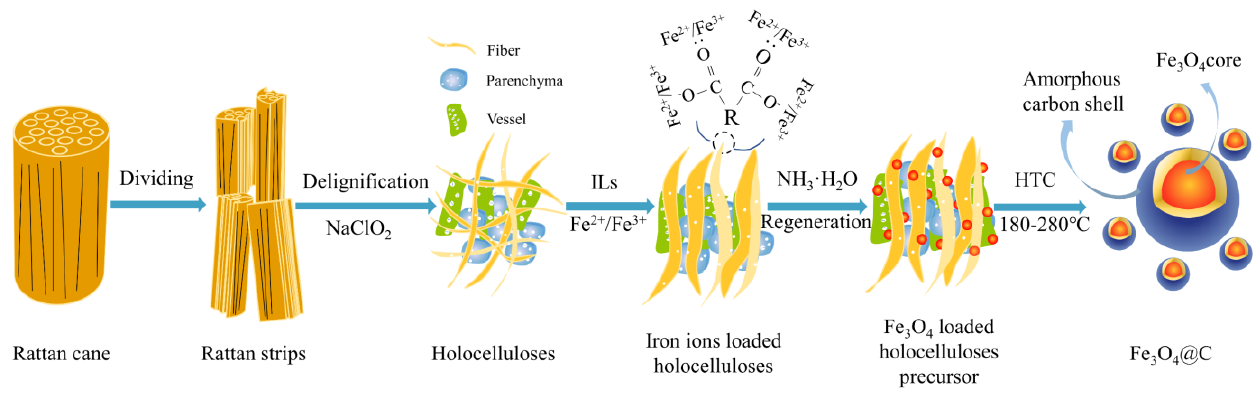
Figure 7. Schematic growth models of the as-obtained Fe 3 O 4 @C nanoparticles.